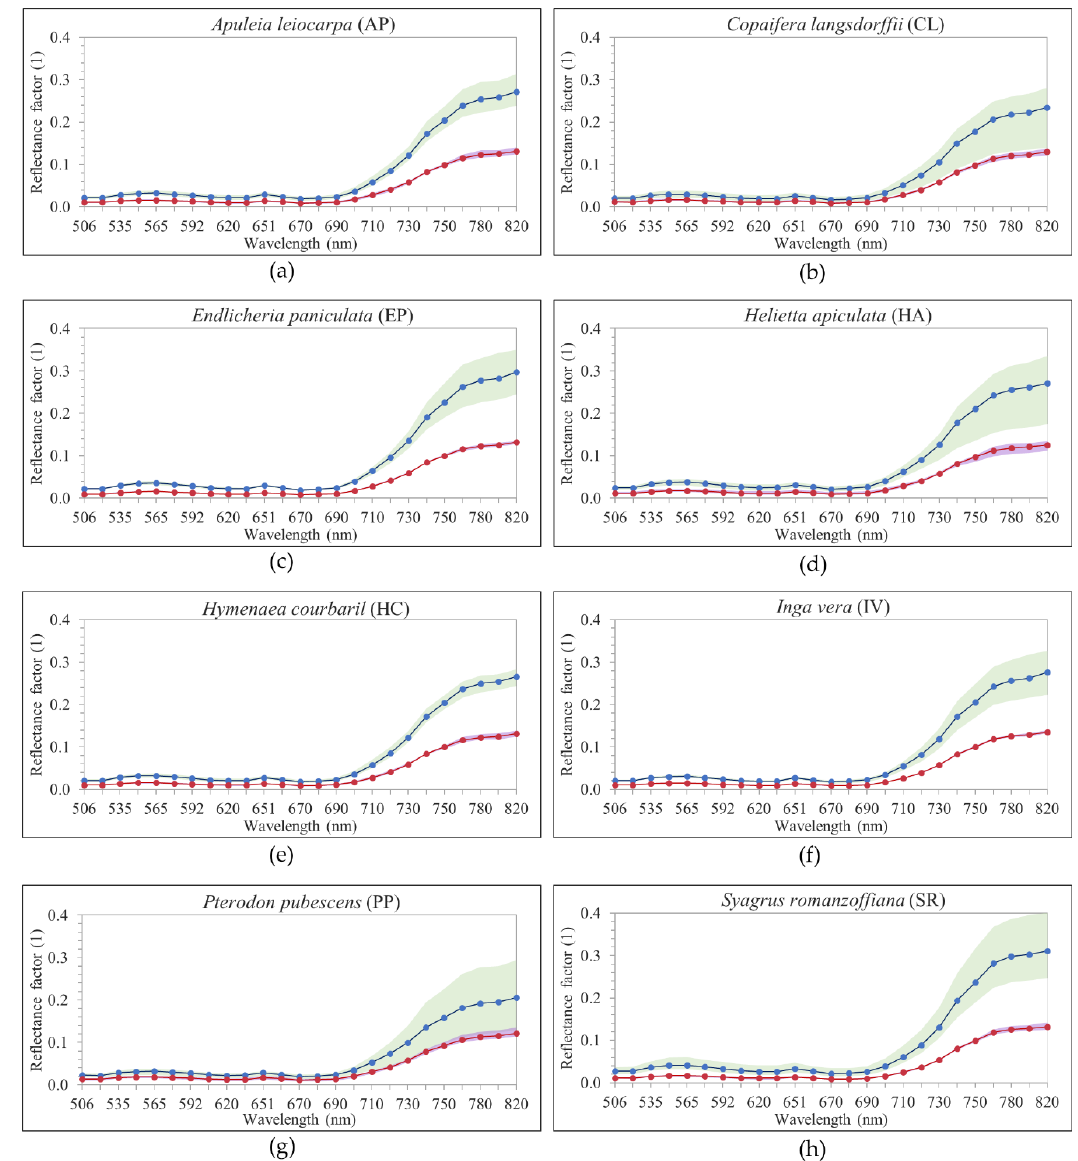
Figure 8. Values for each tree species considering the mean reflectance factor spectra (Mean) and the mean normalized spectra (MeanNorm) calculated using pixels in the delineated crown polygons. The blue line represents the Mean, the red line represents the MeanNorm, and the shaded area represents the minimum and maximum values. ( a ) Apuleia leiocarpa (AP), ( b ) Copaifera langsdorffii (CL), ( c ) Endlicheria paniculata (EP), ( d ) Helietta apiculata (HA), ( e ) Hymenaea courbaril (HC), ( f ) Inga vera (IV), ( g ) Pterodon pubescens (PP), ( h ) Syagrus romanzoffiana (SR).